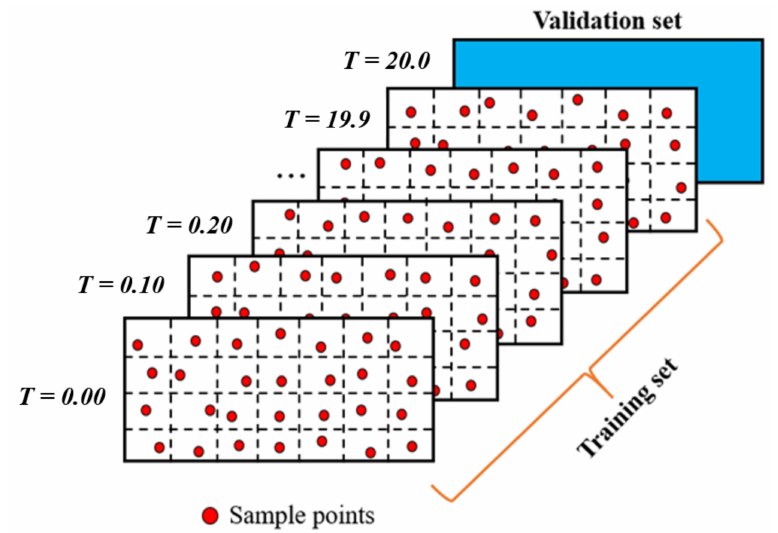
Figure 11. The training set and validation set of the flow past